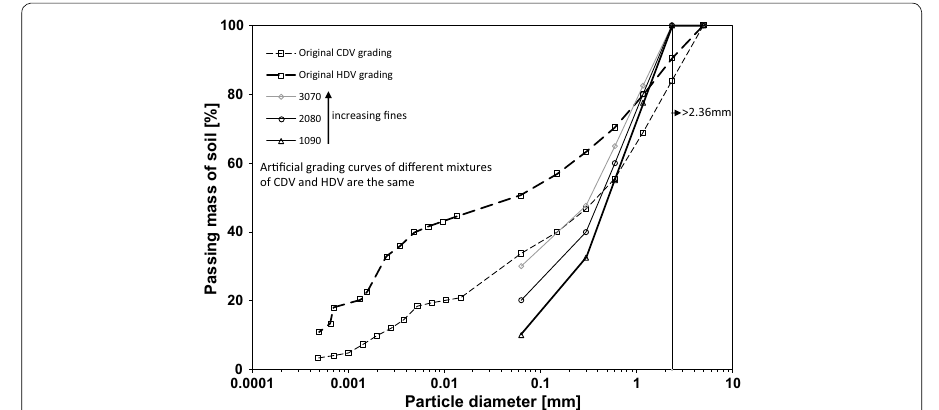
Fig. 2 Particle size distributions for the original soils and different mixtures of CDV and